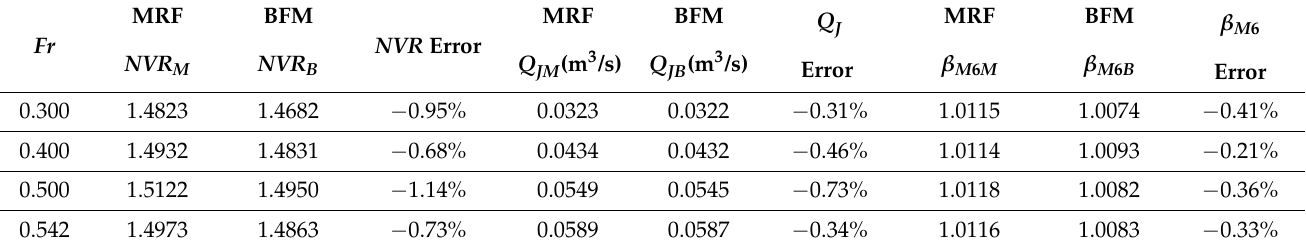
Table 6. Results of 𝑁𝑉𝑅 , 𝑄 (cid:3011) and 𝛽 (cid:3014)(cid:2874) at station 6 with the MRF model and body-force model (BFM).